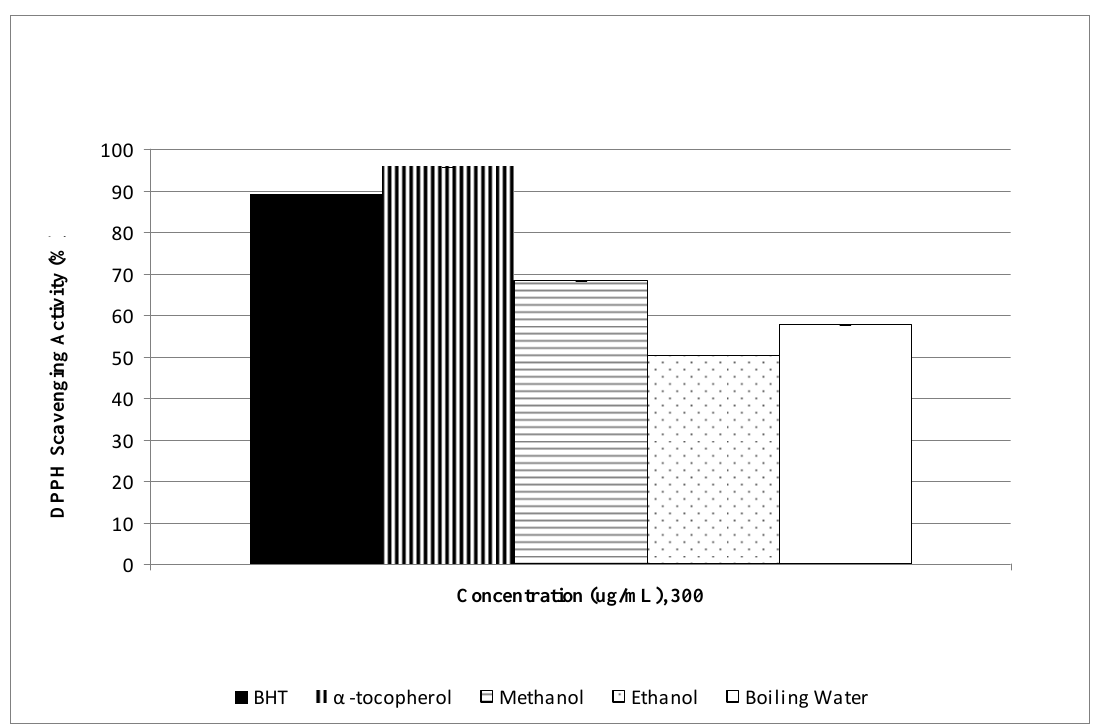
Figure 2. The free radical scavenging activity of C. sativus L. extracts using different solvents and reference antioxidants at 300 μ